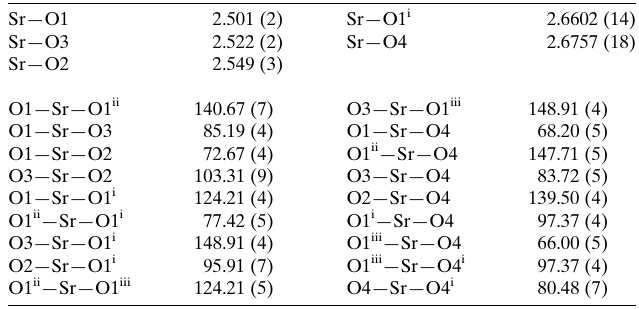
Table 1 Selected geometric parameters (A˚ , (cid:5) ) for (I).